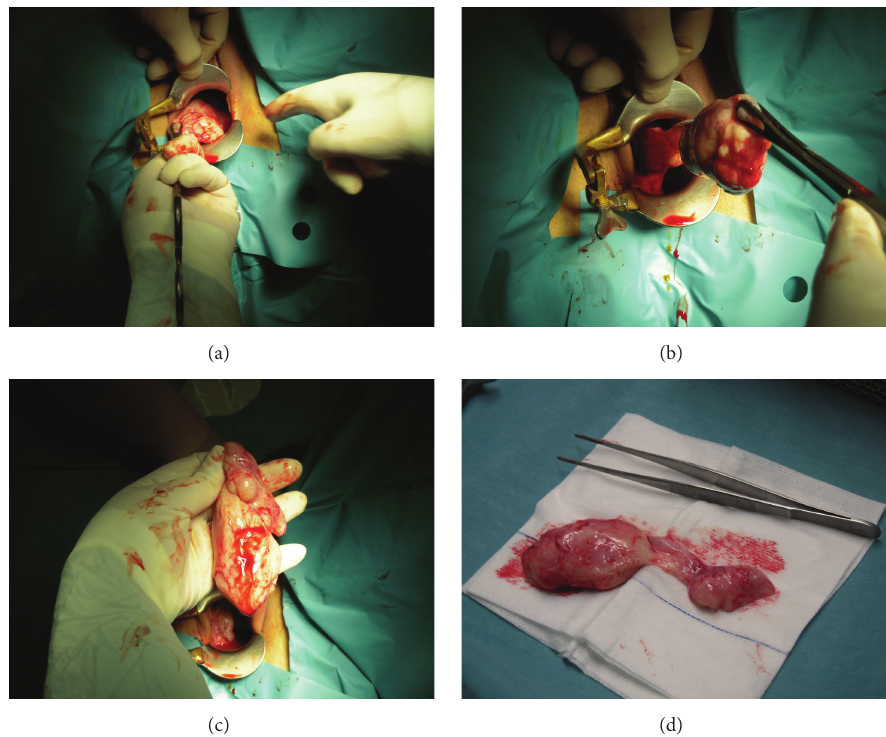
Figure 1: (a) Gelatinous mass arising from lateral vaginal wall. (b)-(c) Surgical excision of the mass. (d) Excised pedunculated mass being about 12cm long.